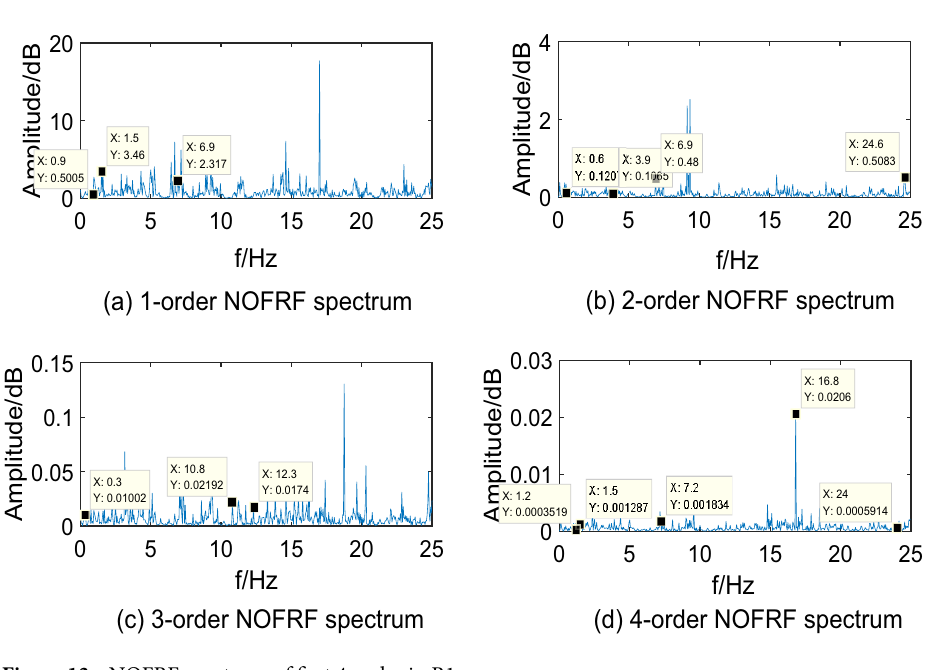
Figure 13. NOFRF spectrum of first 4-order in